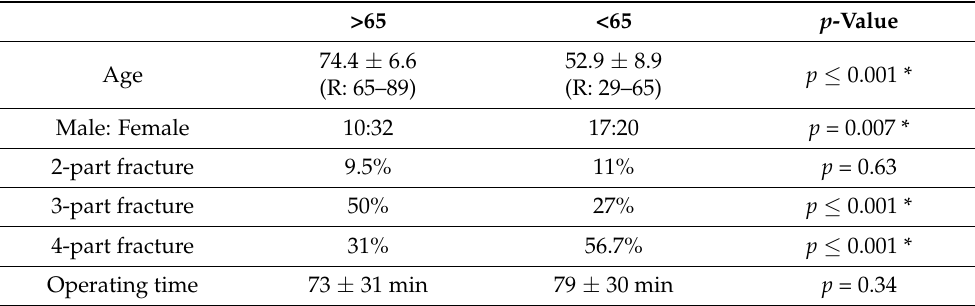
Table 2. Age, gender, and fracture pattern distribution of the age groups over and under 65 years treated with a locking plate. Whilst there is no significant difference in the allocation of 2-part fractures ( p = 0.63), there is a significant increase in 4-part fractures ( p ≤ 0.001) in the age group over 65. R stands for Range in this table and * for statistical